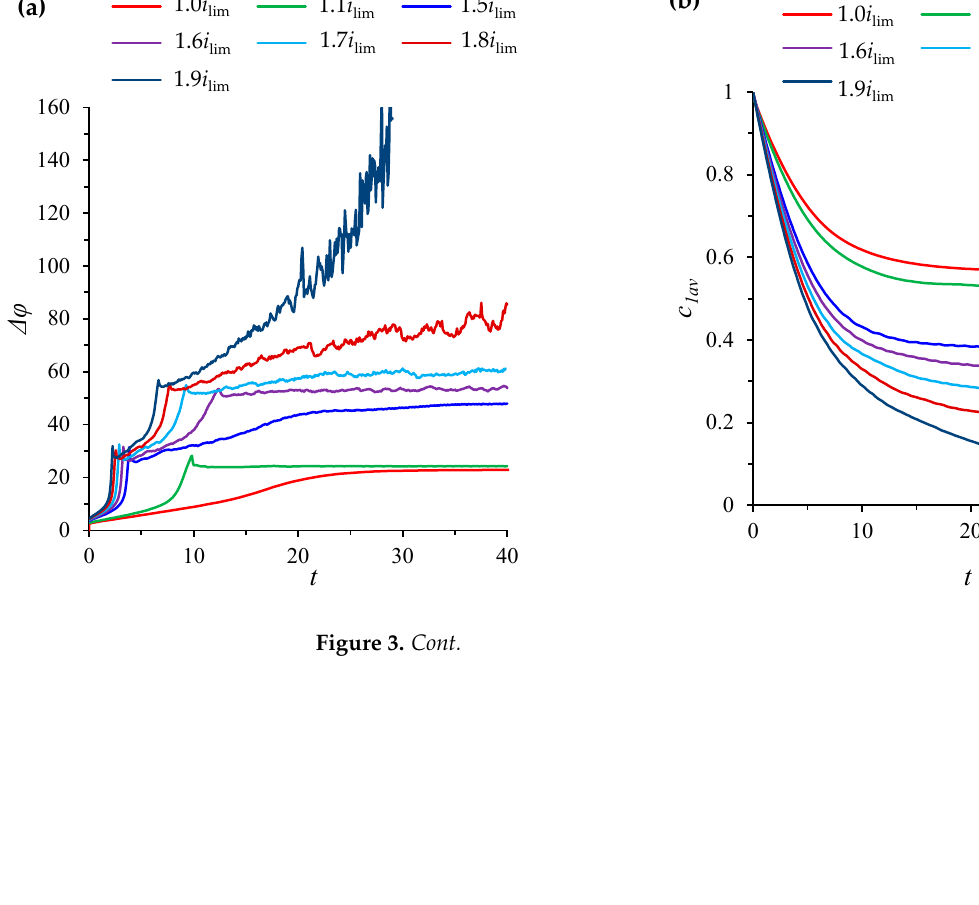
Figure 3. ChPs ( a ), time dependencies of the average concentration of cations in the desalination channel,   =